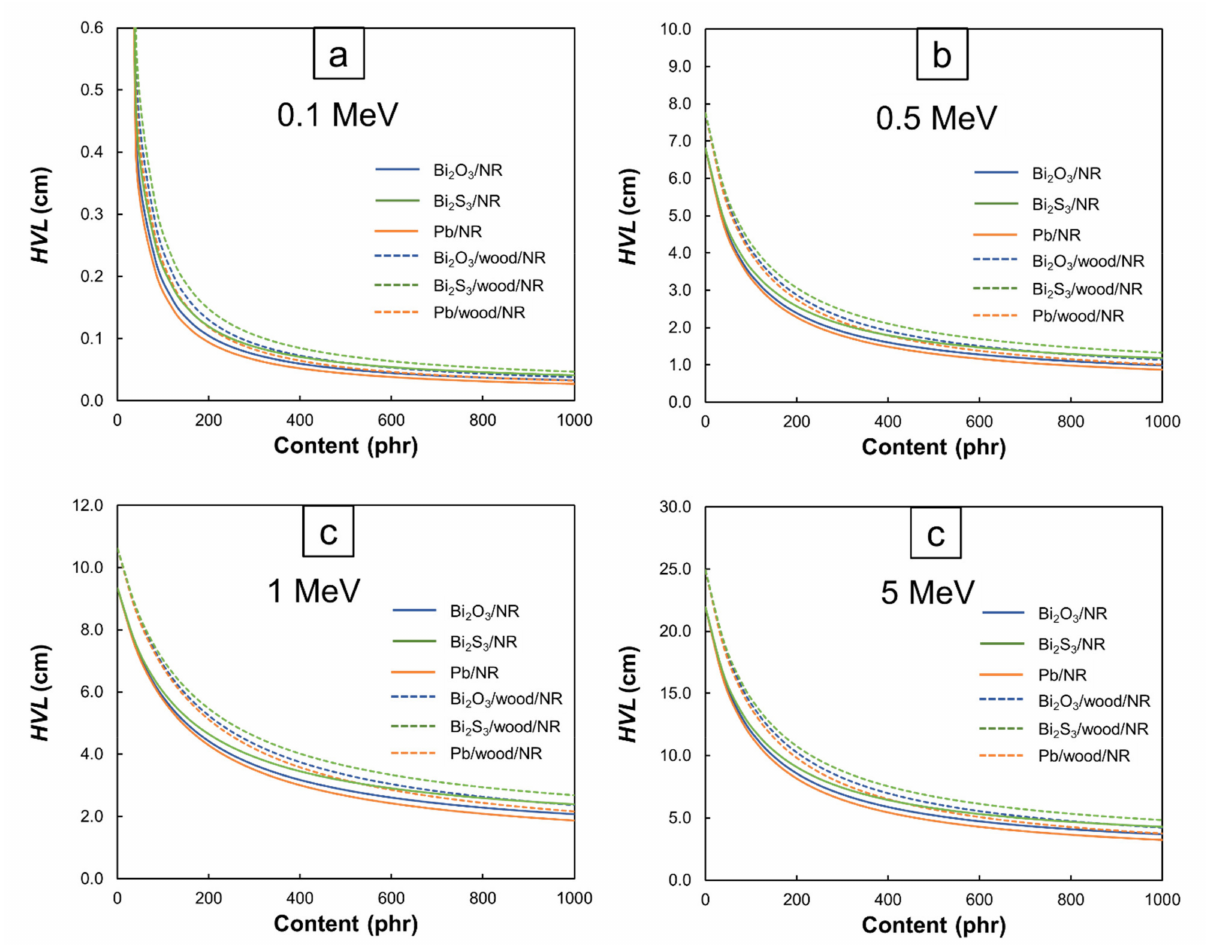
Figure 8. HVL values of Bi 2 O 3 /NR, Bi 2 S 3 /NR, Pb/NR, Bi 2 O 3 /wood/NR, Bi 2 S 3 /wood/NR, and Pb/wood/NR composites at photon energies of ( a ) 0.1 MeV, ( b ) 0.5 MeV, ( c ) 1 MeV, and ( d ) 5